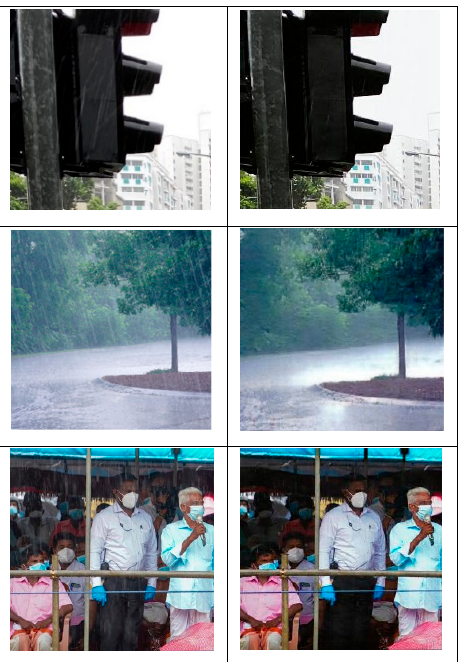
Figure 3. CGANet on real-world dataset (( Left ) Input image; ( Right ) de-rained